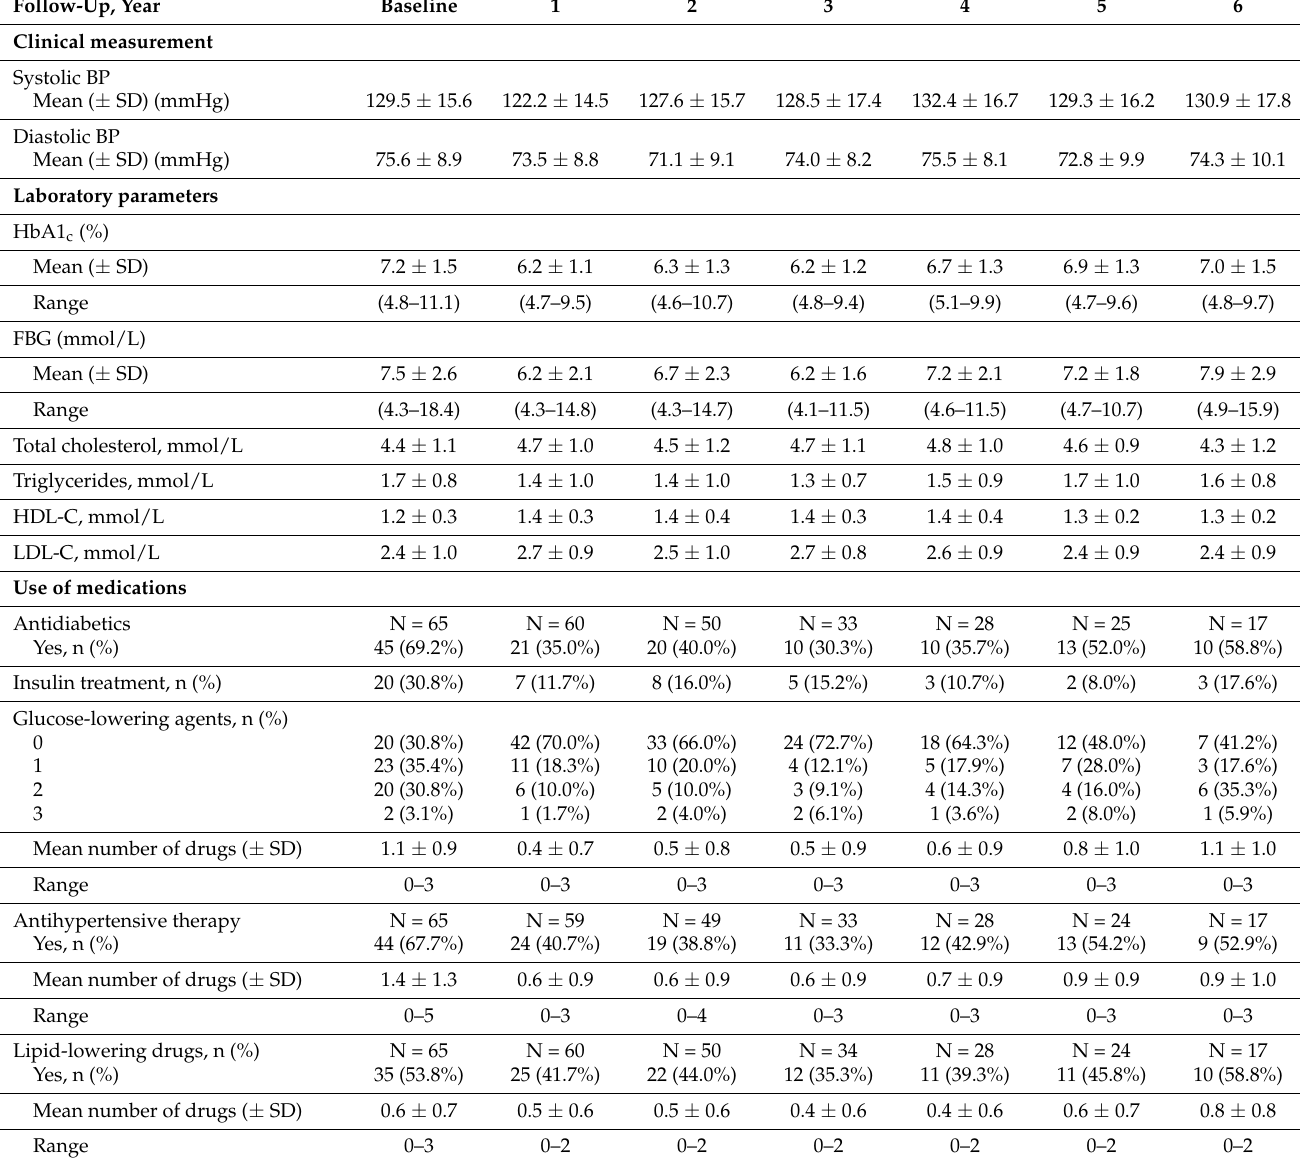
Table 3. Yearly clinical profiles of all study patients pre- and post-bariatric surgery (n =